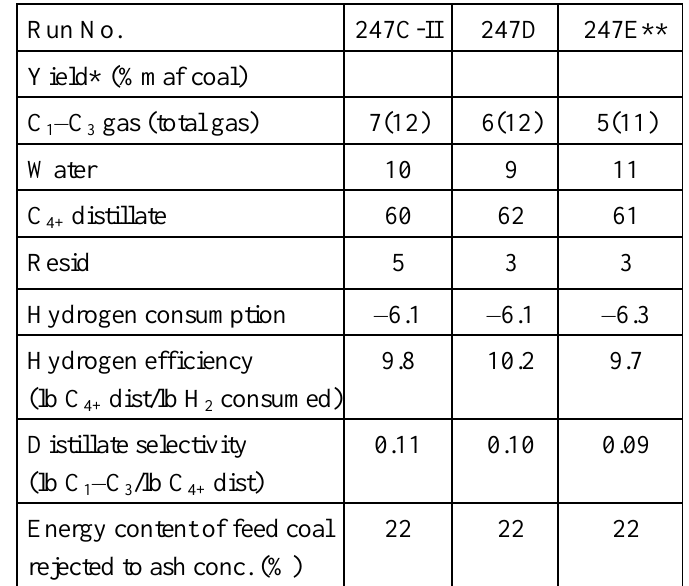
Table 14. RITSL yield structures (thermal/catalytic) (Wilsonville pilot plant). Illinois Bituminous